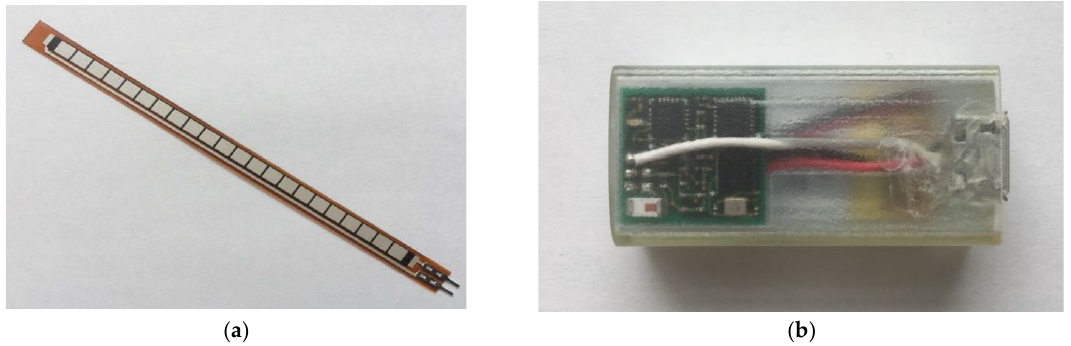
Figure 7. Sensors and data collection devices: ( a ) bending sensor; ( b ) WonderSense.